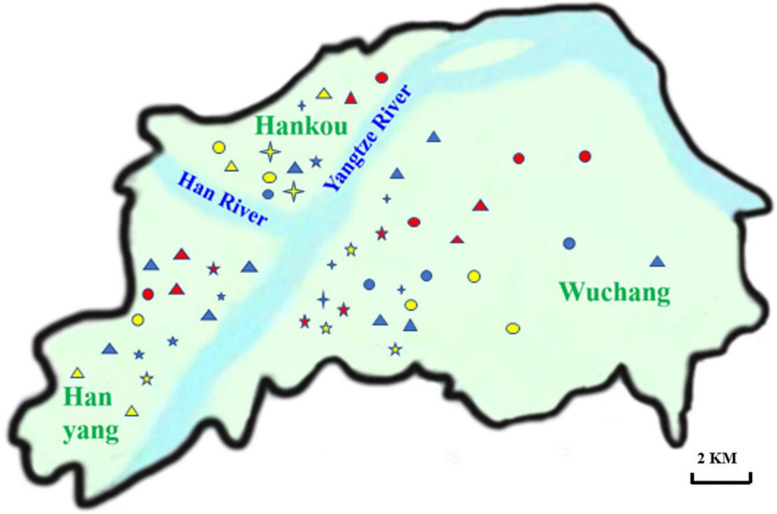
Distribution of supermarket chains in Wuhan. The names of 11 supermarket chains distributed in Hanyang, Hankou and Wuchang were labeled on the Wuhan map. The abbreviations of supermarket chains were listed as follows. , W; , M; , Z; , Y; , H; , L; , S; , J; , P; , D; , A.